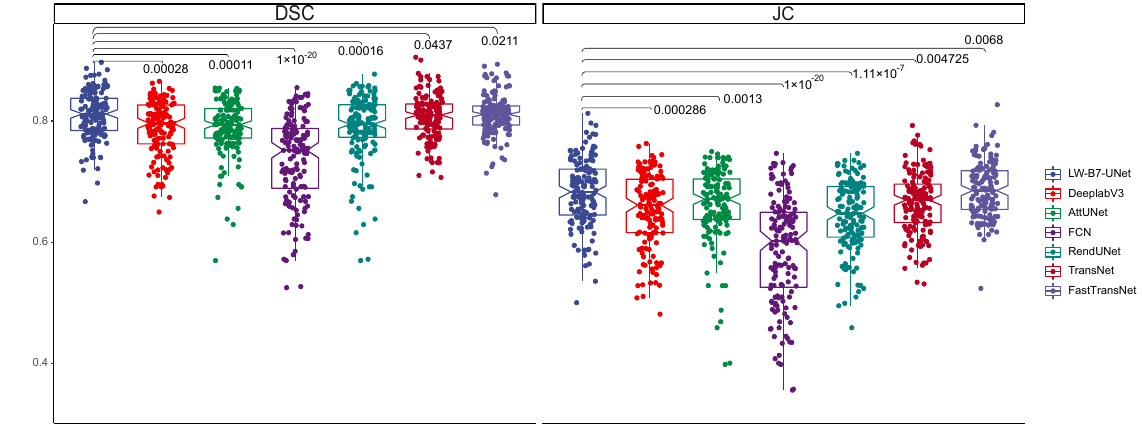
Figure 4. Box plots of the DSC and JC values obtained from the tests on the test set and its Kruskal– Wallis results. The results show that our model achieves the highest DSC and JC values in the test of nasopharyngeal carcinoma segmentation and is significantly different from other models.